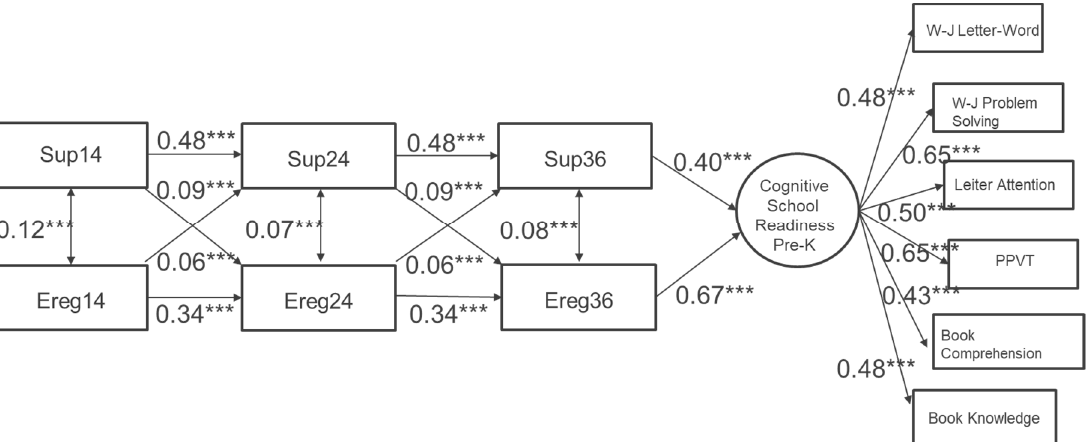
Figure 2. A final generalized autoregressive model for repeated measures of parent supportiveness and child emotion regulation with cross-lagged effects and a distal outcome. *** p ≤ 0.001